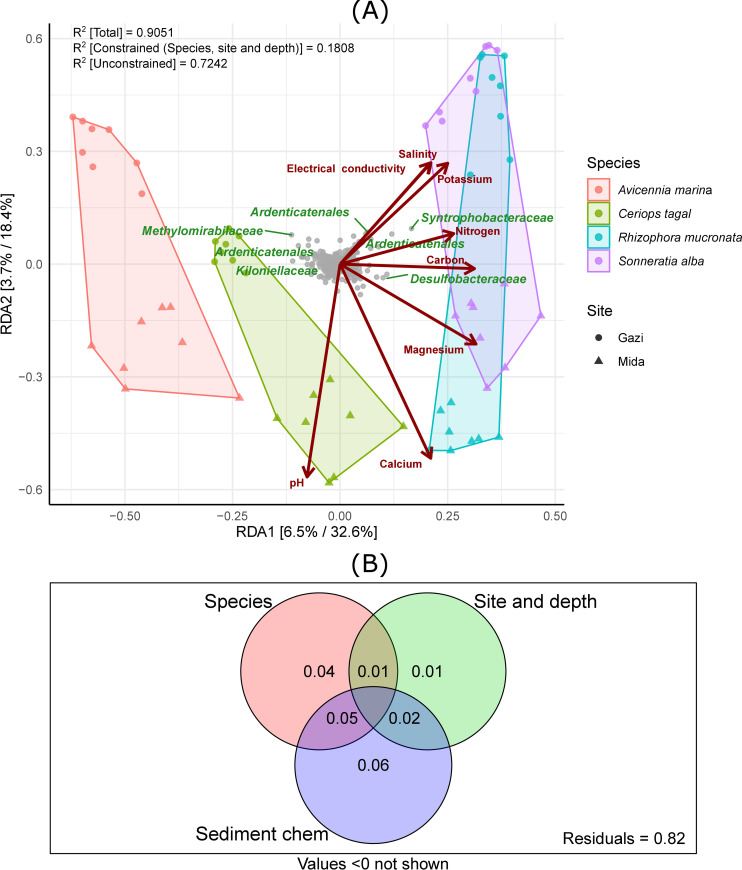
Constrained redundancy analysis displaying contributions of environmental factors to bacterial community composition (A) and (B) variation in the bacterial community structure explained by species, site/depth differences and physicochemical parameters (Ca, Mg, N, P, K, EC, salinity, pH, Na and C). *Note only environmental variables with p-value of at least 0.01 are displayed.